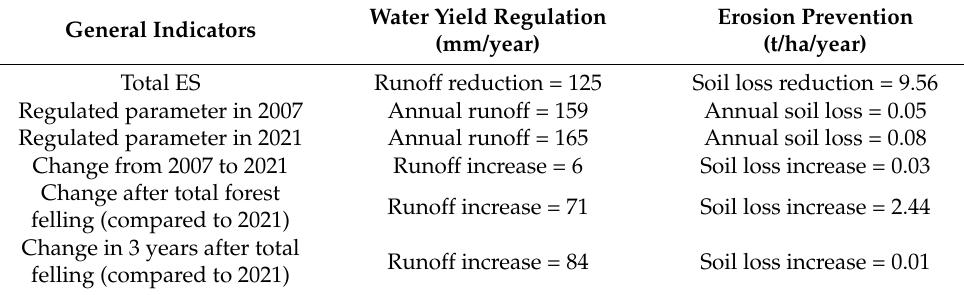
Table 1. Total ES values and changes in regulated